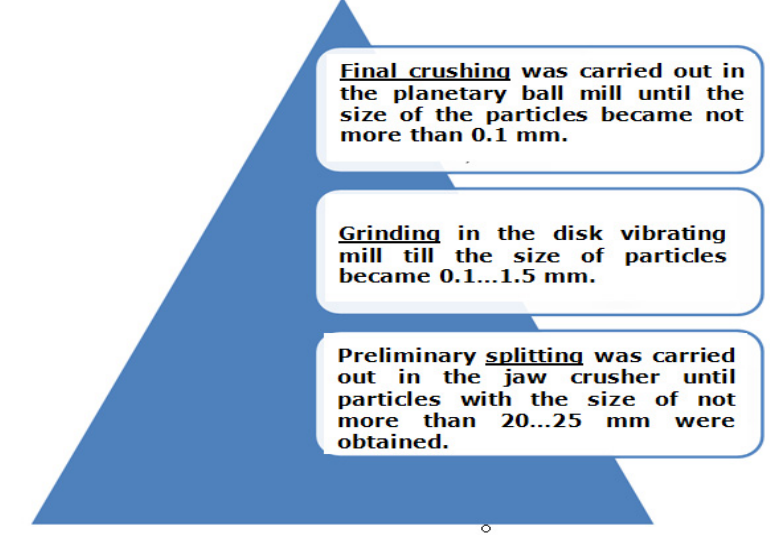
Figure 6. Grinding diagram Al-W-B waste into powder material at various stages. Further grinding of the material into powder was carried out in a disintegrator [36], which makes it possible to obtain finer fractions of the material (Figure 7).